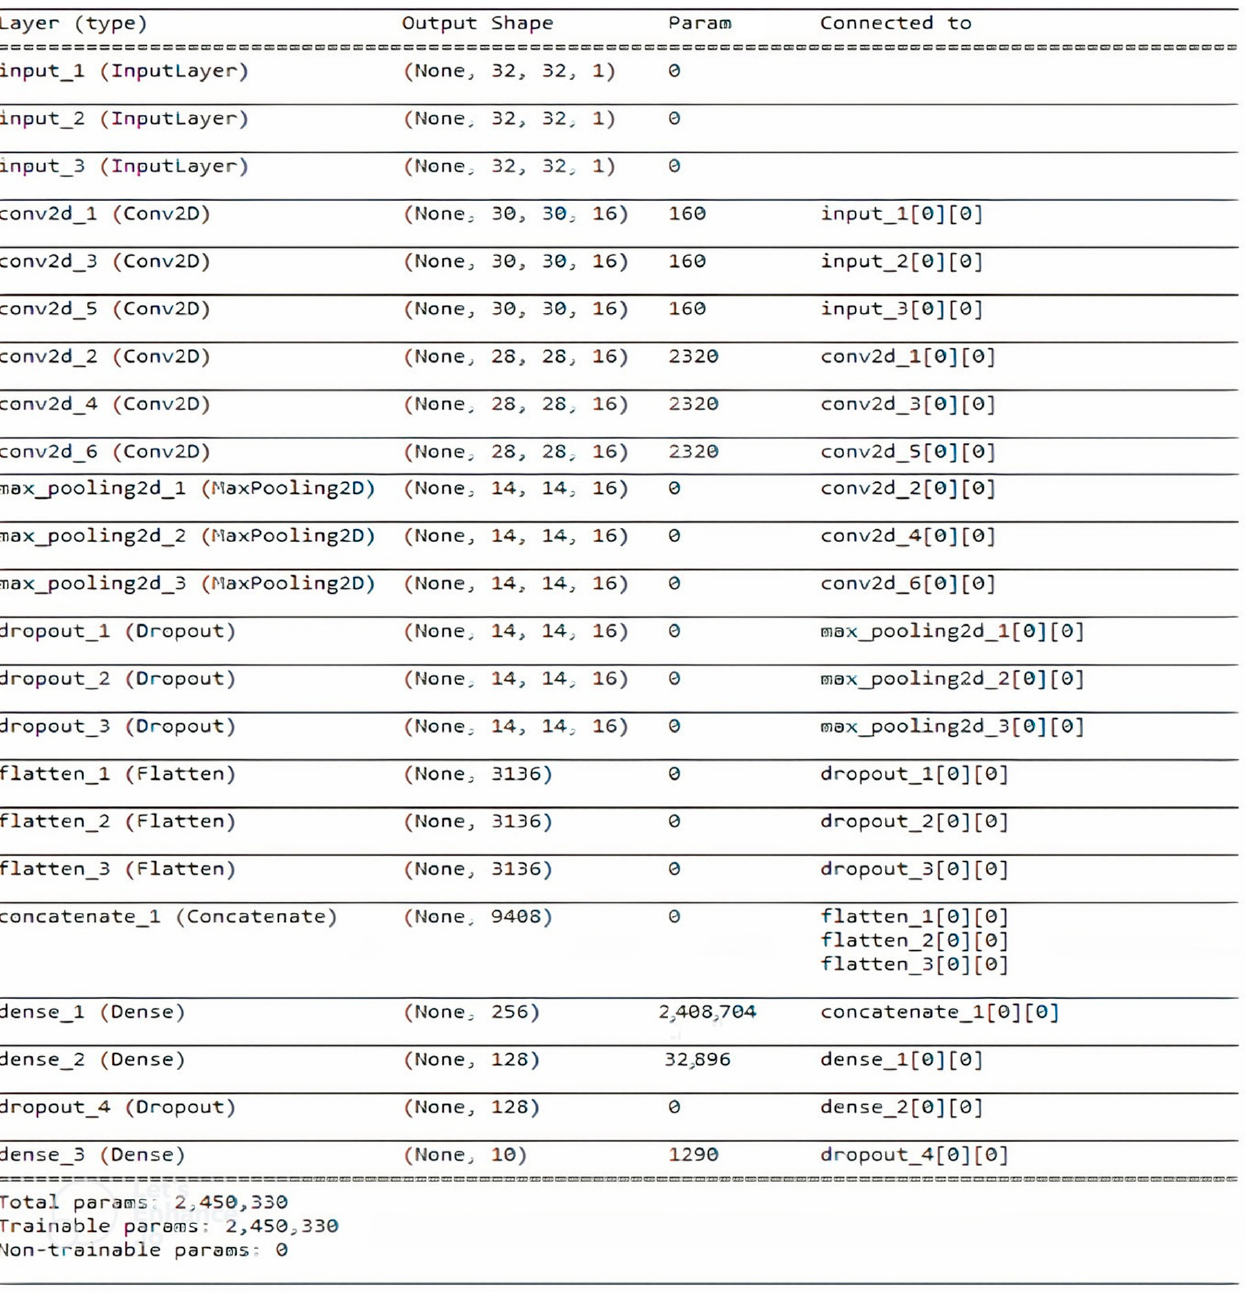
Figure 5. A summary of the CNN configuration for a combination case named “K” using a Mol2mat